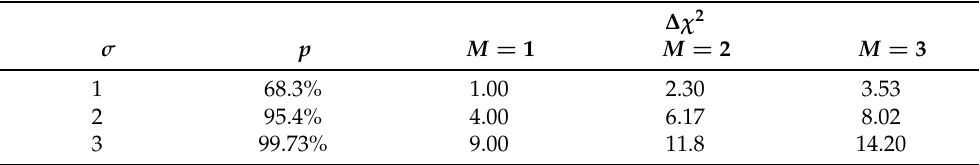
Table 3. ∆ χ 2 for the conventional 68.3%, 95.4%, and 99.73% as a function of the number of parameters ( M ) for the joint confidence